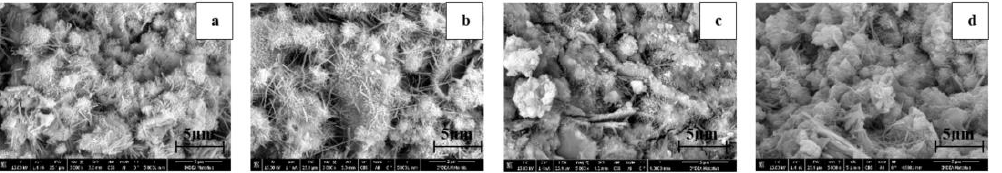
Figure 3. Thermogravimetric curves for the control sample, the 0.02 wt.% SWCNTs and the 0.02 wt.% MWCNTs reinforced cement samples, after 7 days of curing time.